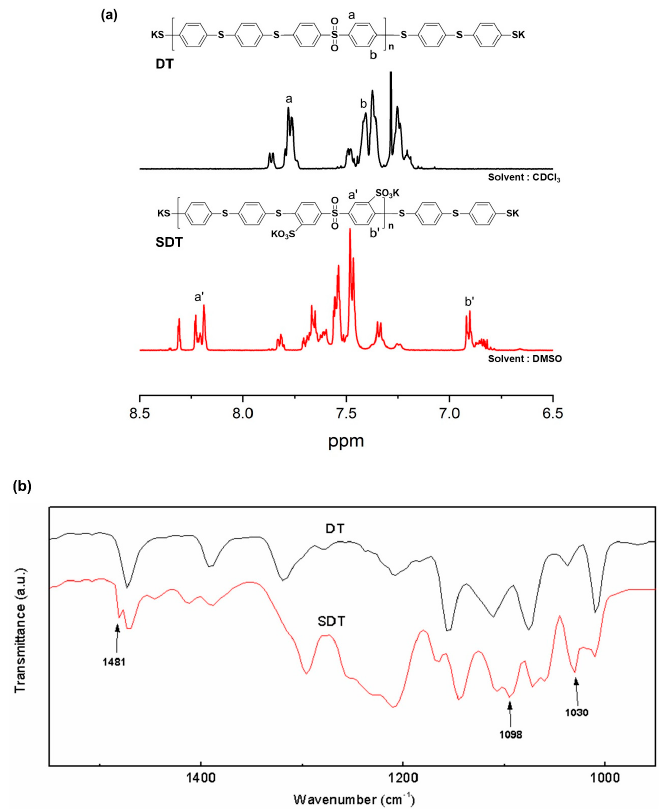
Figure 2. ( a ) 1 H-NMR and ( b ) FT-IR spectra of DT and